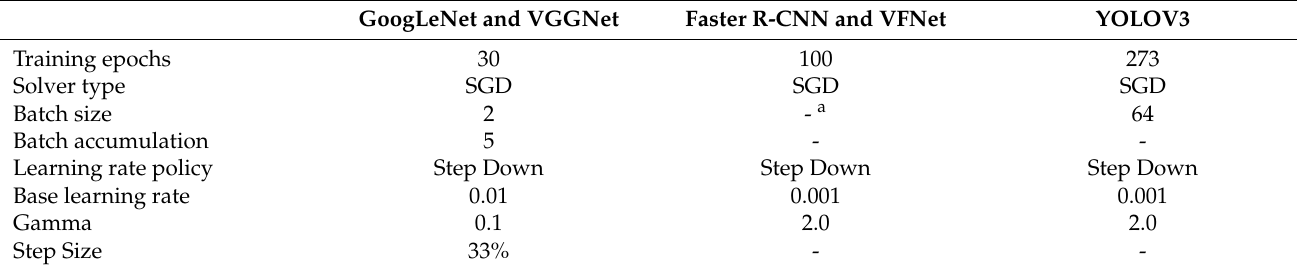
Table 1. Hyper-parameters used for training the neural